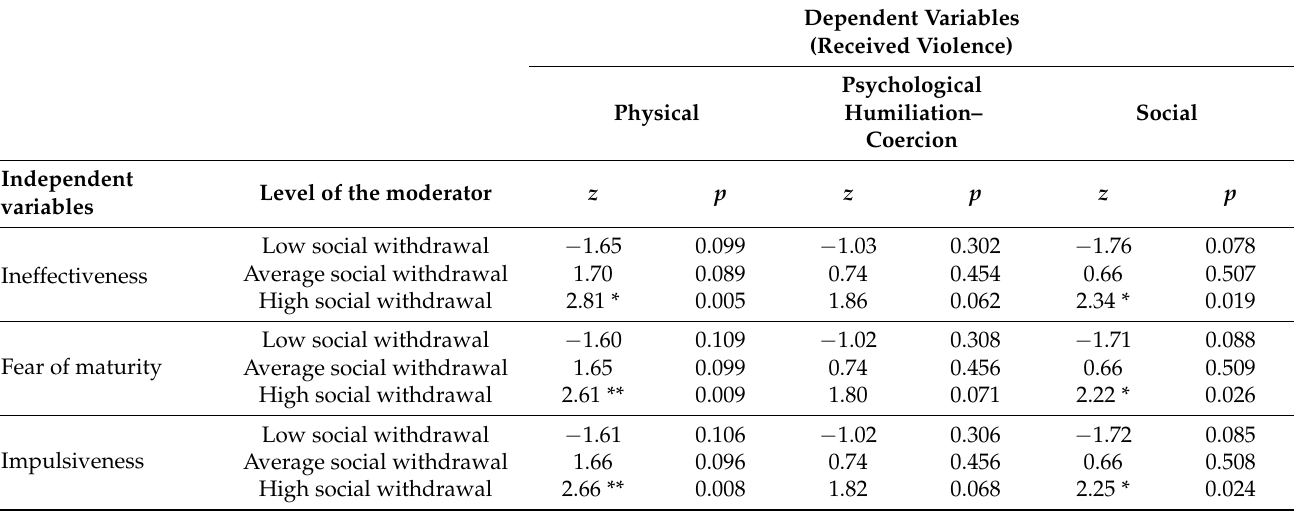
Table 4. Moderated indirect effects of ineffectiveness, fear of maturity and impulsiveness on physical, psychological humiliation–coercion and social received violence through fear of